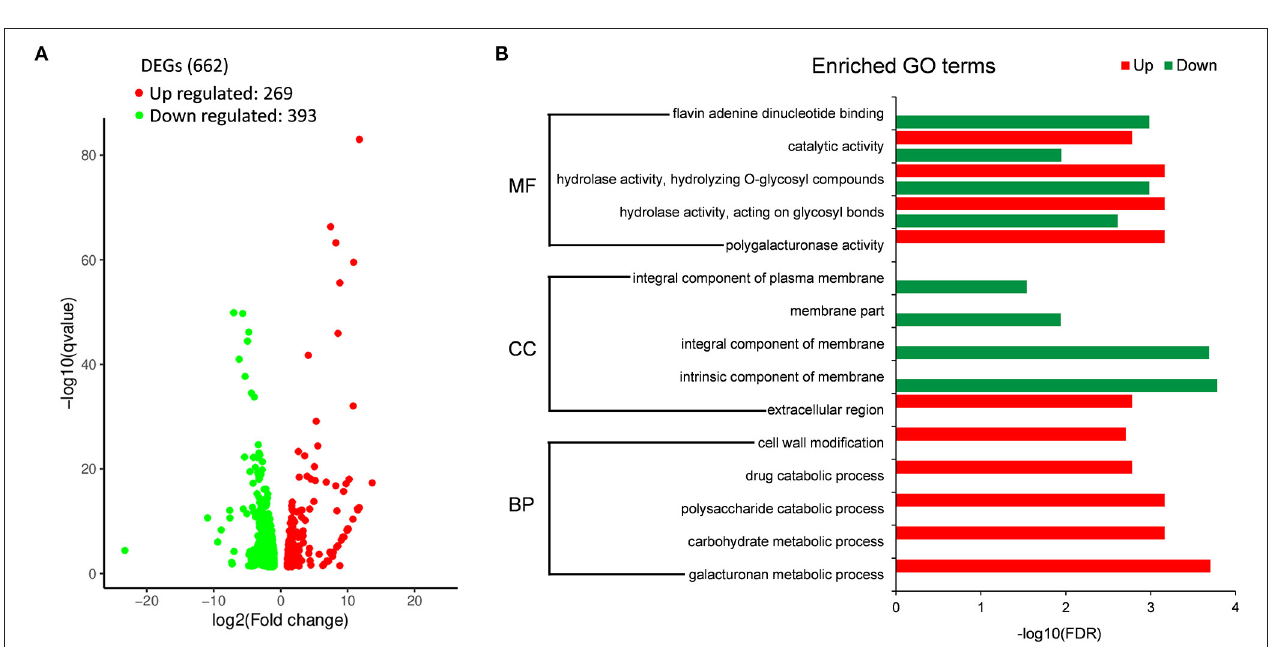
FIGURE 4 | Pathogenicity assays of the Sscnd1 gene-silenced strains. (A) Disease phenotype of the wild-type strain (WT), empty vector strain (EV), Sicnd1-9 and Sicnd1-20 on the unwounded (UW) and wounded (W, wounded with a dissecting needle) leaves of rapeseed. Photographs were taken at 48 hpi. One representative biological replicate is shown. (B) Statistical analysis of the lesion area in panels (A) . Error bars indicate the standard deviation for five replicates. Differences in the UW group and W group were assessed using Tukey’s HSD test, respectively. Different letters indicate statistical significance at the 0.05 level ( P < 0.05).